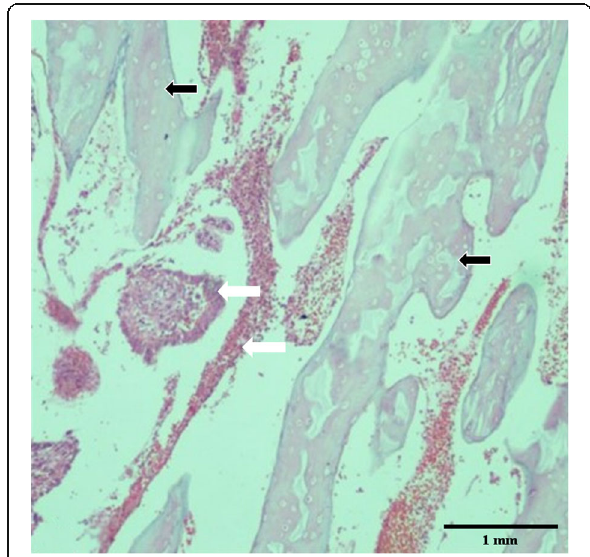
Fig. 7 Low power (10×) view photomicrograph showing endometrial glands and stroma (white block arrows) infiltrated by lamellar (black block arrows) bone (EOM). Endometrial stroma is also infiltrated by lymphocytes. Areas of haemorrhage are also seen